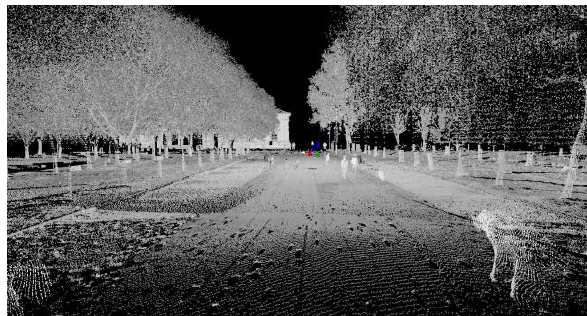
Figure 9. Palazzo Te external scan view from